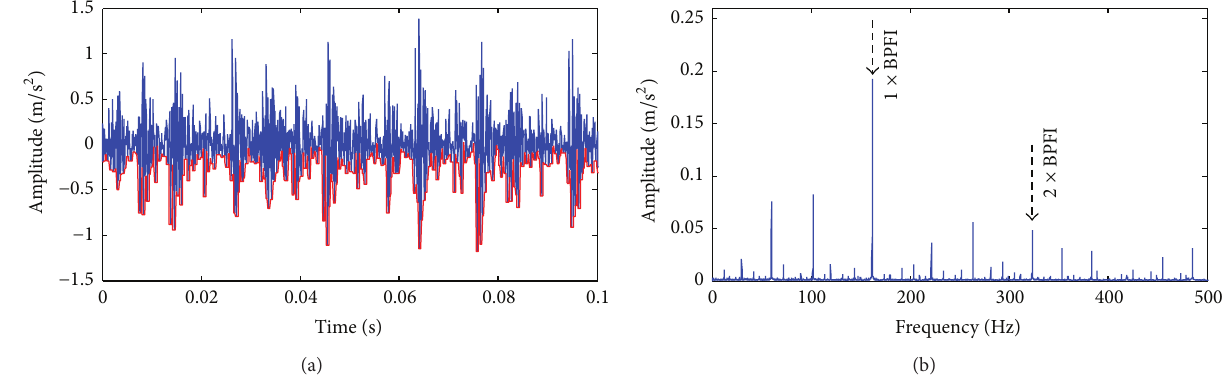
Figure 9: (a) Results of morphological operation erosion; (b) frequency spectrum of (a).